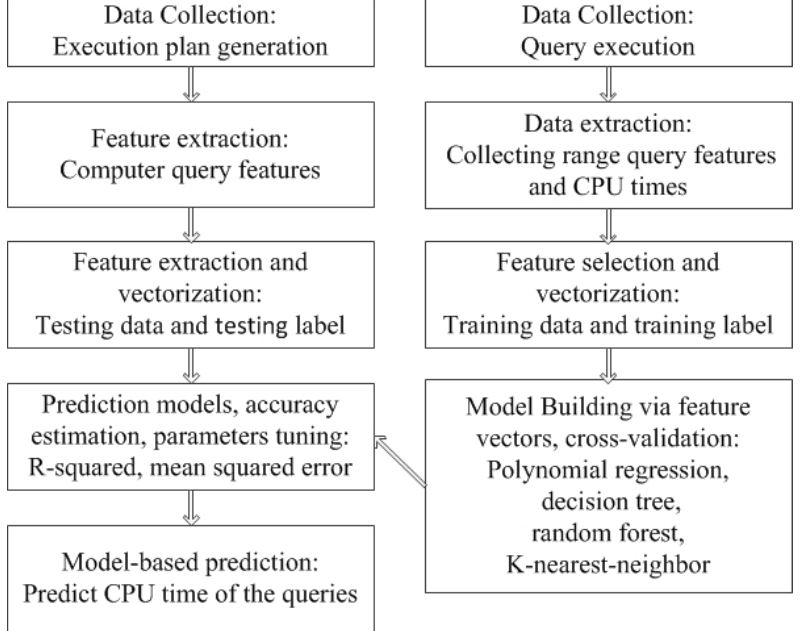
Figure 1. The architecture of